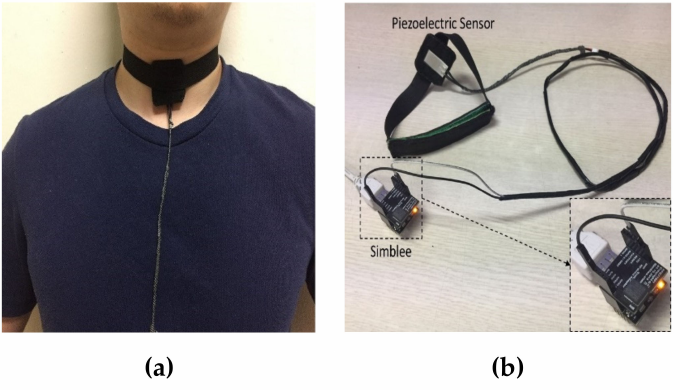
Figure 3. Necklace-type wearable system: ( a ) Subject wearing a necklace; ( b ) Necklace connected to